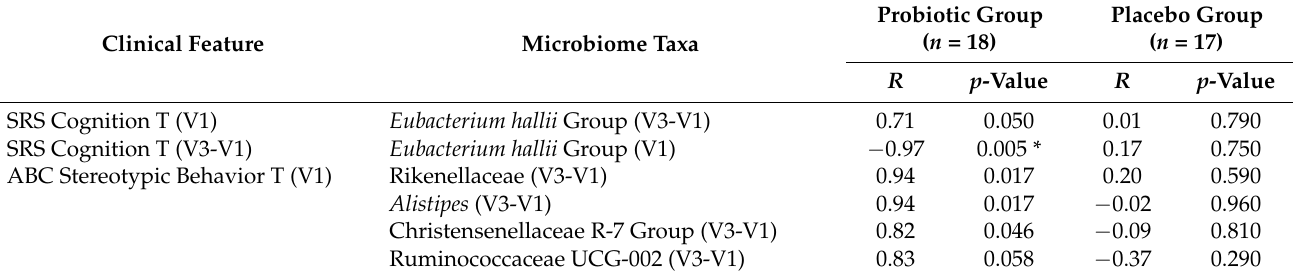
Table 3. Spearman correlations between the microbiota relative abundance and socio-behavioral parameters before treatment for all subjects.